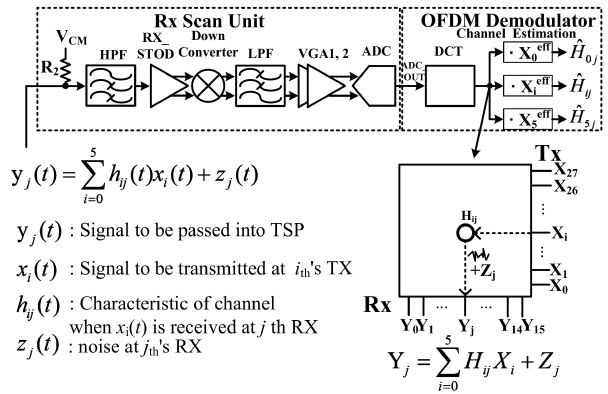
Figure 7. Conceptual diagram of the receiver.